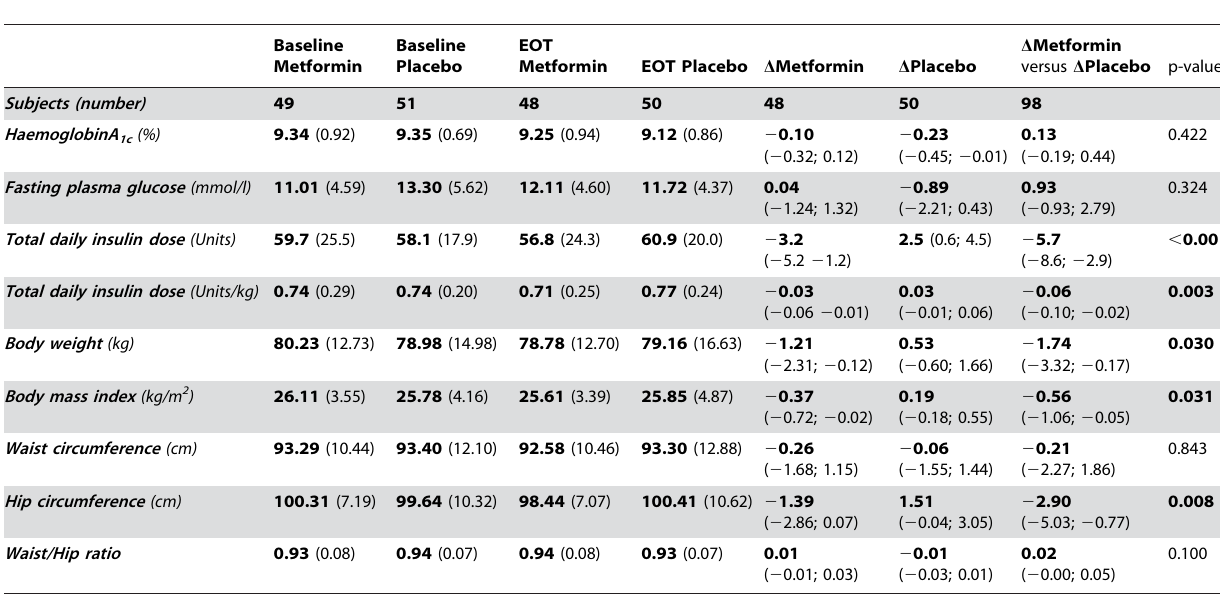
Table 3. Metabolism-related variables in 100 patients with type-1 diabetes before and after one year of treatment with metformin or placebo.